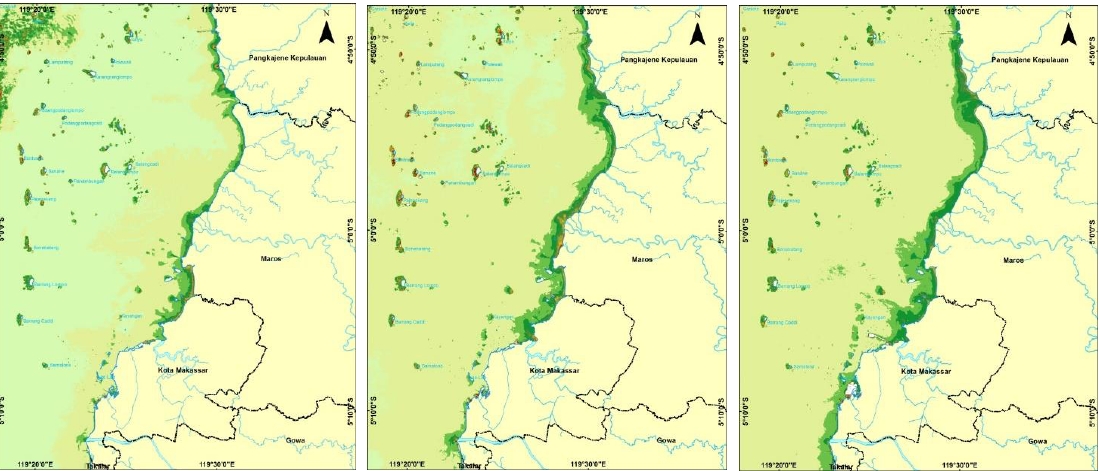
Figure 7. TSS distribution around Distribution around Bontosua and Ballang Caddi island and near from the main land and shore lines Spermonde waters in the transition season of the west season to the east season, (a) 2013, (b) 2016, (c) 2018-2019